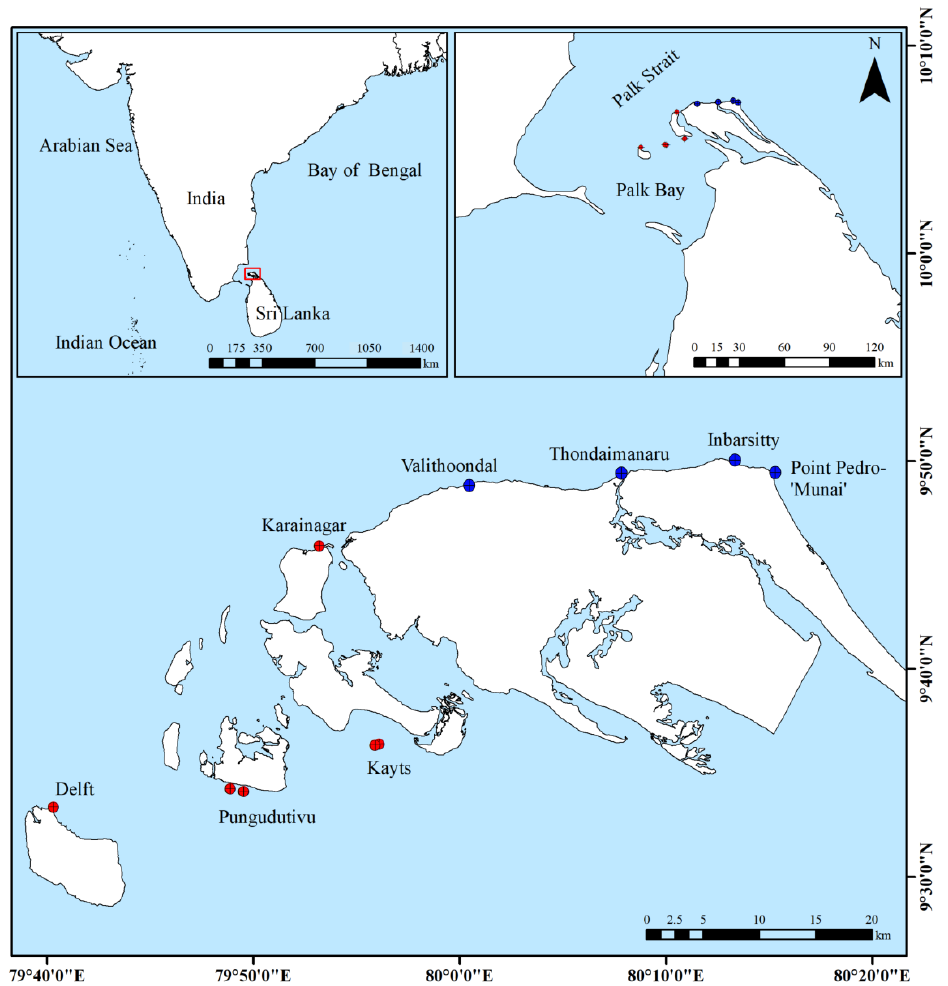
Figure 1. Maps showing ( above left ) the location of the Jaffna Peninsula (within the red rectangle) in relation to Sri Lanka and southern India, ( above right ) the relation of the Jaffna Peninsula to the Palk Strait and Palk Bay, and ( below ) the locations of the study sites (blue circles) on the northern side and the island sites (red circles) of the Jaffna Peninsula and its adjacent